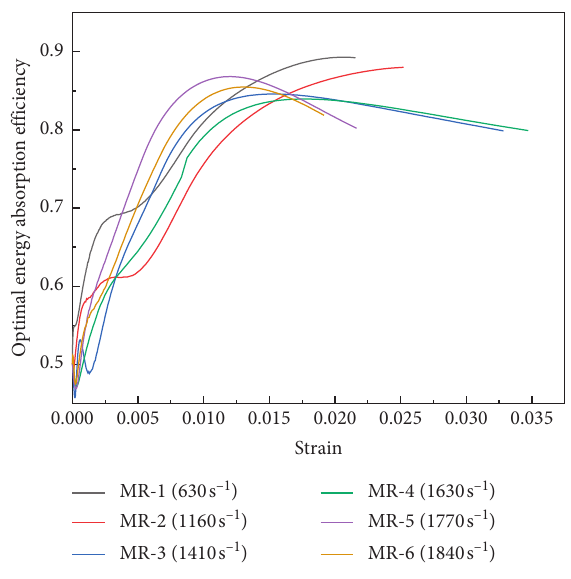
Figure 9: I − ε curves.